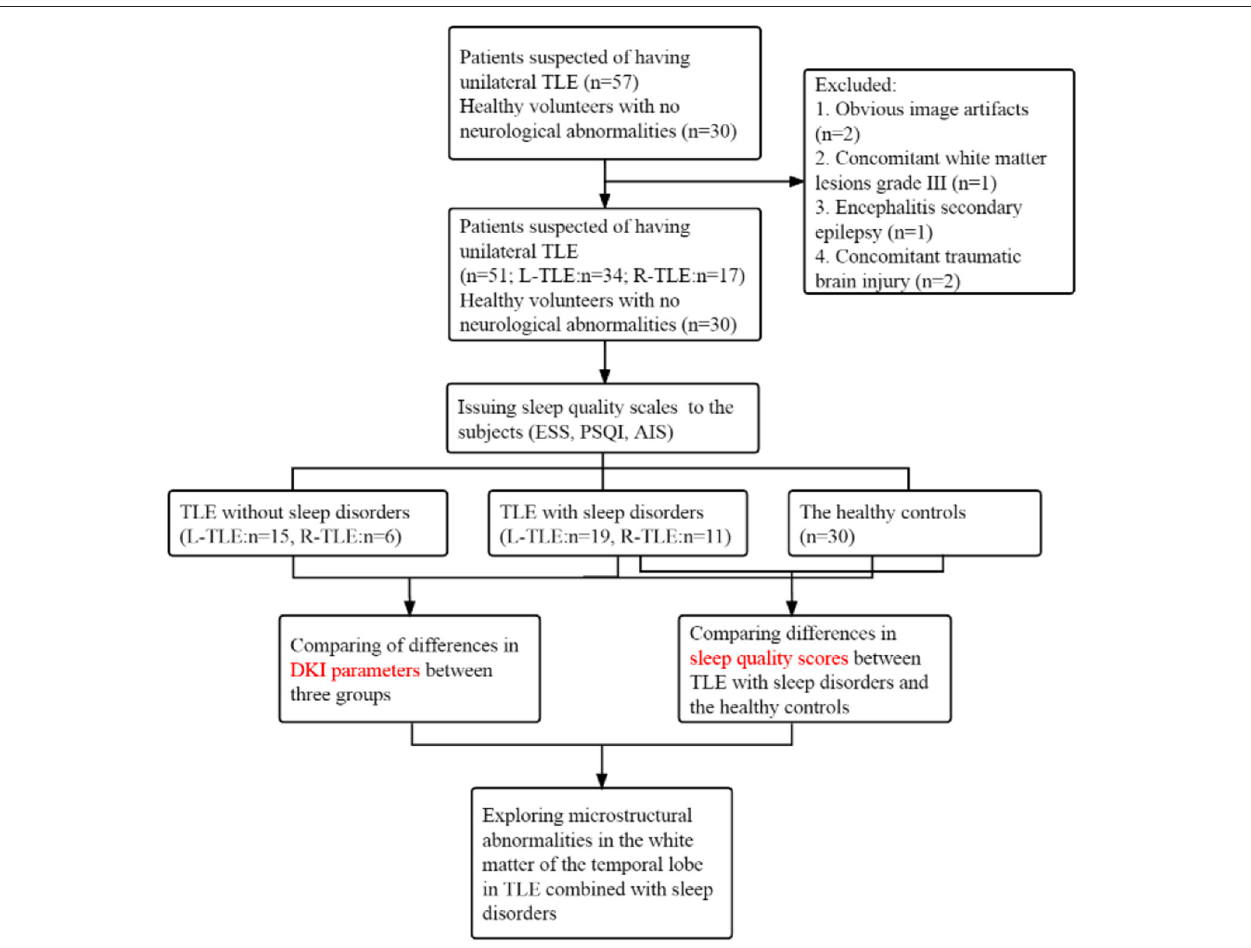
FIGURE 1 | A flow chart is used to show the implementation method of the